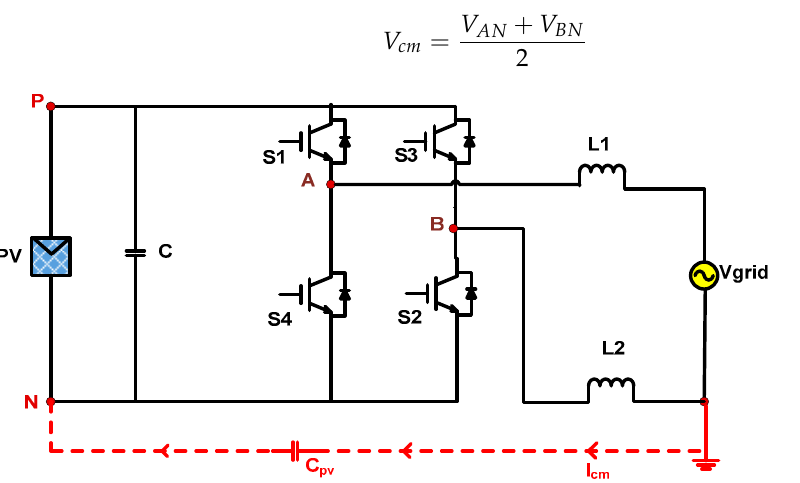
Figure 4. Analysis of leakage current in full-bridge (H4) inverter circuit connected to the grid. Differential mode voltage ( V dm ) is the difference between the inverter output terminals and reference negative terminal. It is given by Equation